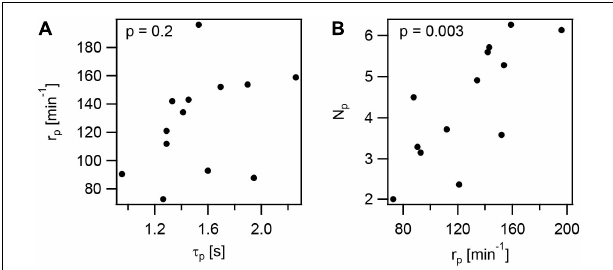
FIGURE 7 | Correlations in T4P dynamics and production rate. The data plotted are mean values from independent experiments at the different conditions investigated in this study. (A) Rate of T4P production as a function of the T4P lifetime. (B) Rate of T4P production as a function of the number of T4P per cell. p -values were obtained from 2-tailed test for the hypothesis that there is no